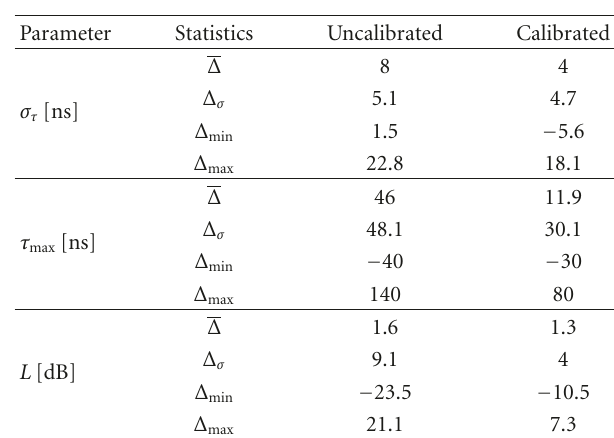
Table 3: Overall prediction error of the model before and after calibration.